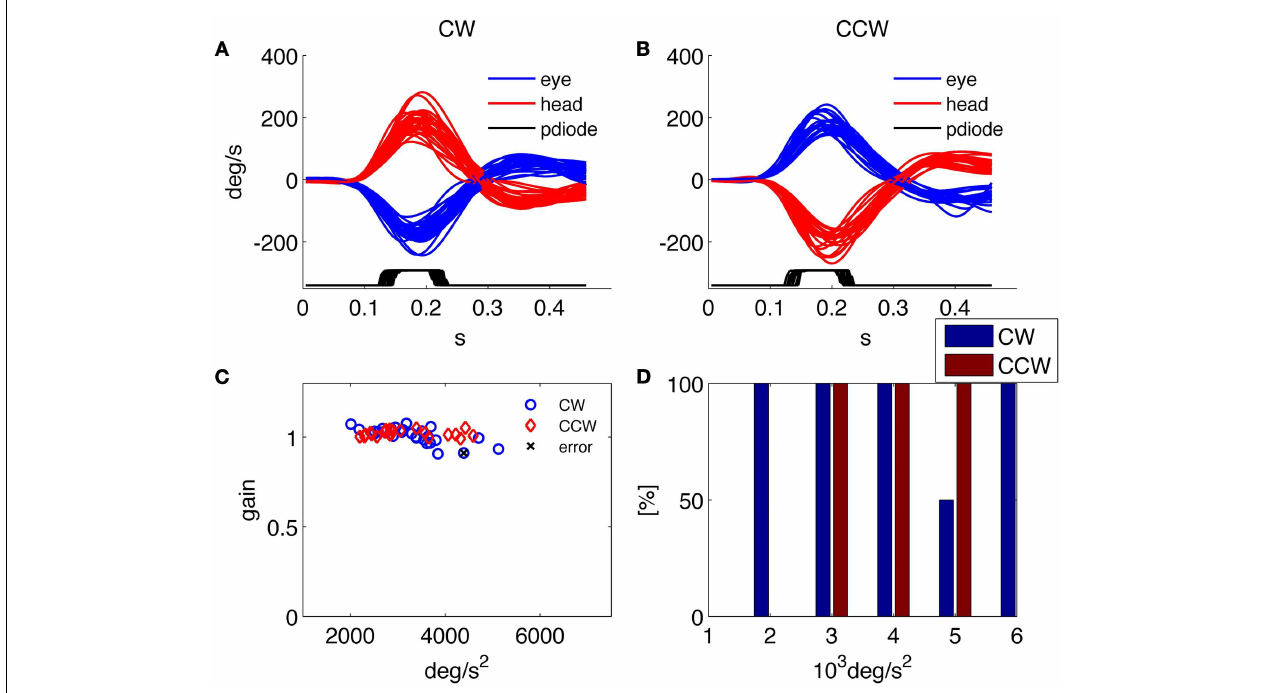
FIGURE 3 | Results of the HITD test on a healthy subject . (A,B) Head and eye movement for CW and CCW rotations, respectively. (C) Plot ofVOR gain values computed for each movement. (D) Percentage of correct answers for each acceleration bin.